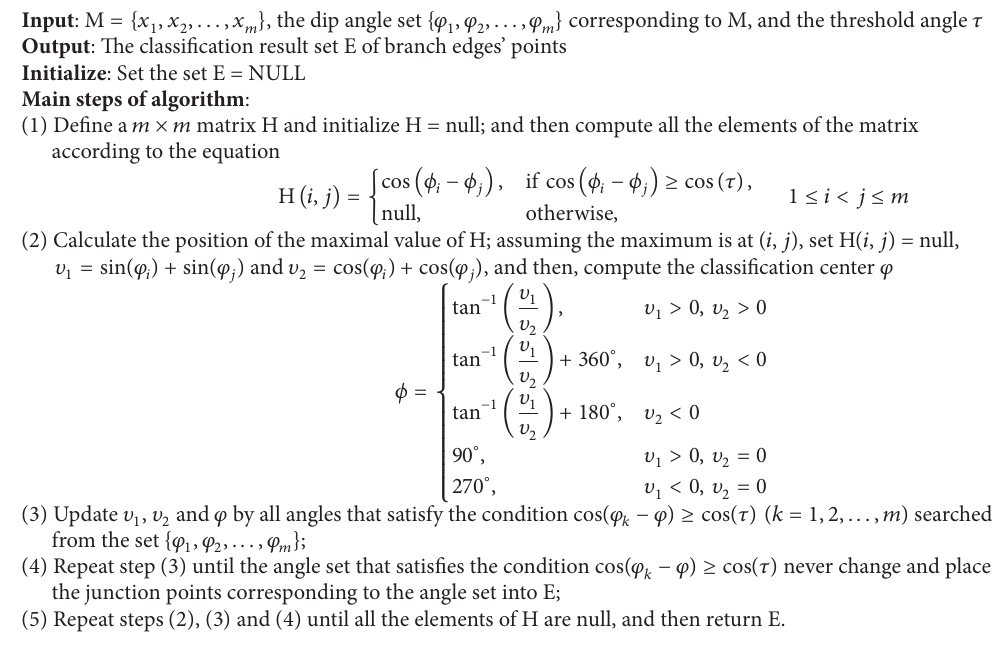
Algorithm 1: Junction point classification